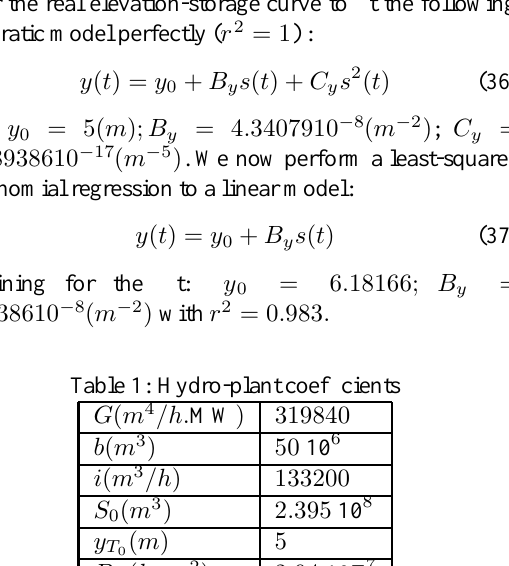
Table 1: Hydro-plant coefficients G ( m 4 /h. MW )